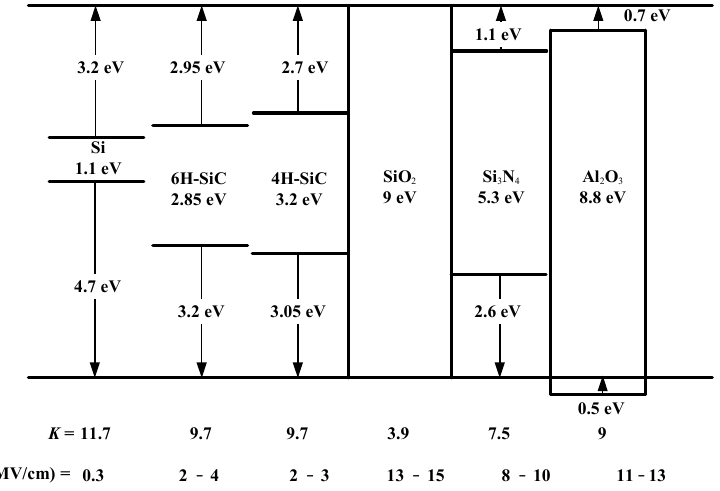
Figure 4. Band structures and band offsets of Si, 6H-SiC, 4H-SiC, SiO 2 , Si 3 N 4 , and Al 2 O 3